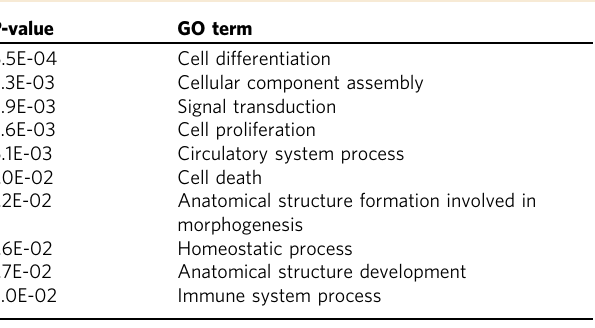
Table 1 Top ten Gene Ontology (GO) terms enriched for genes with signi fi cant 3 ′ UTR shortening through APA regulation by